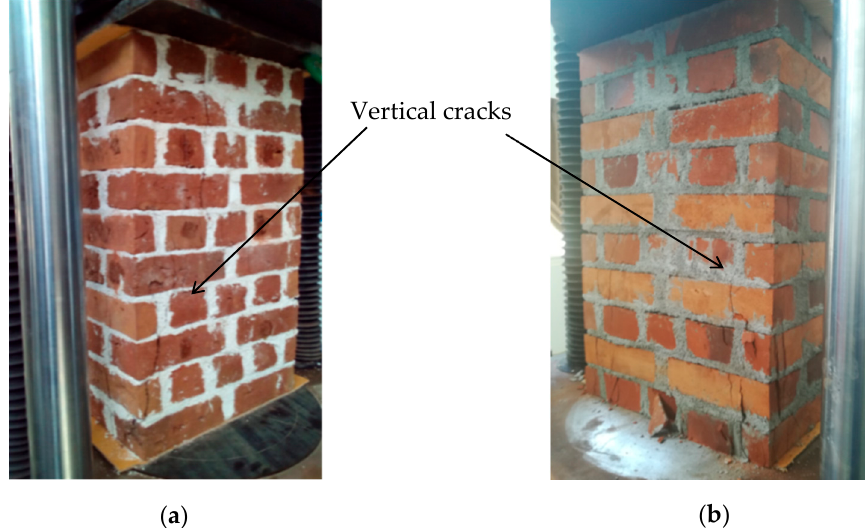
Figure 3. Failure modes of wallettes under cyclic compression ( a ) CB1-NHL mortared wallettes and ( b ) CB2-CM mortared wallettes.